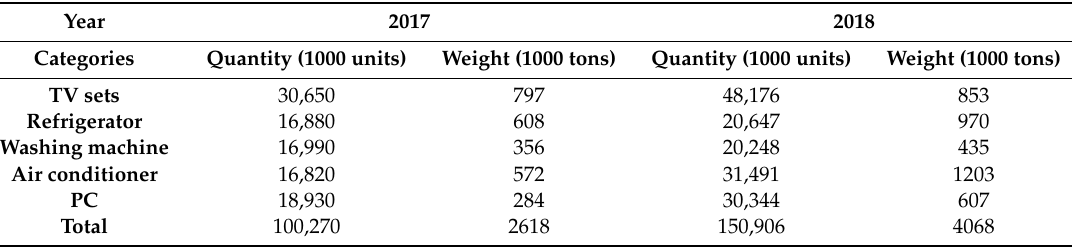
Table 2. Annual generation of waste home appliance in